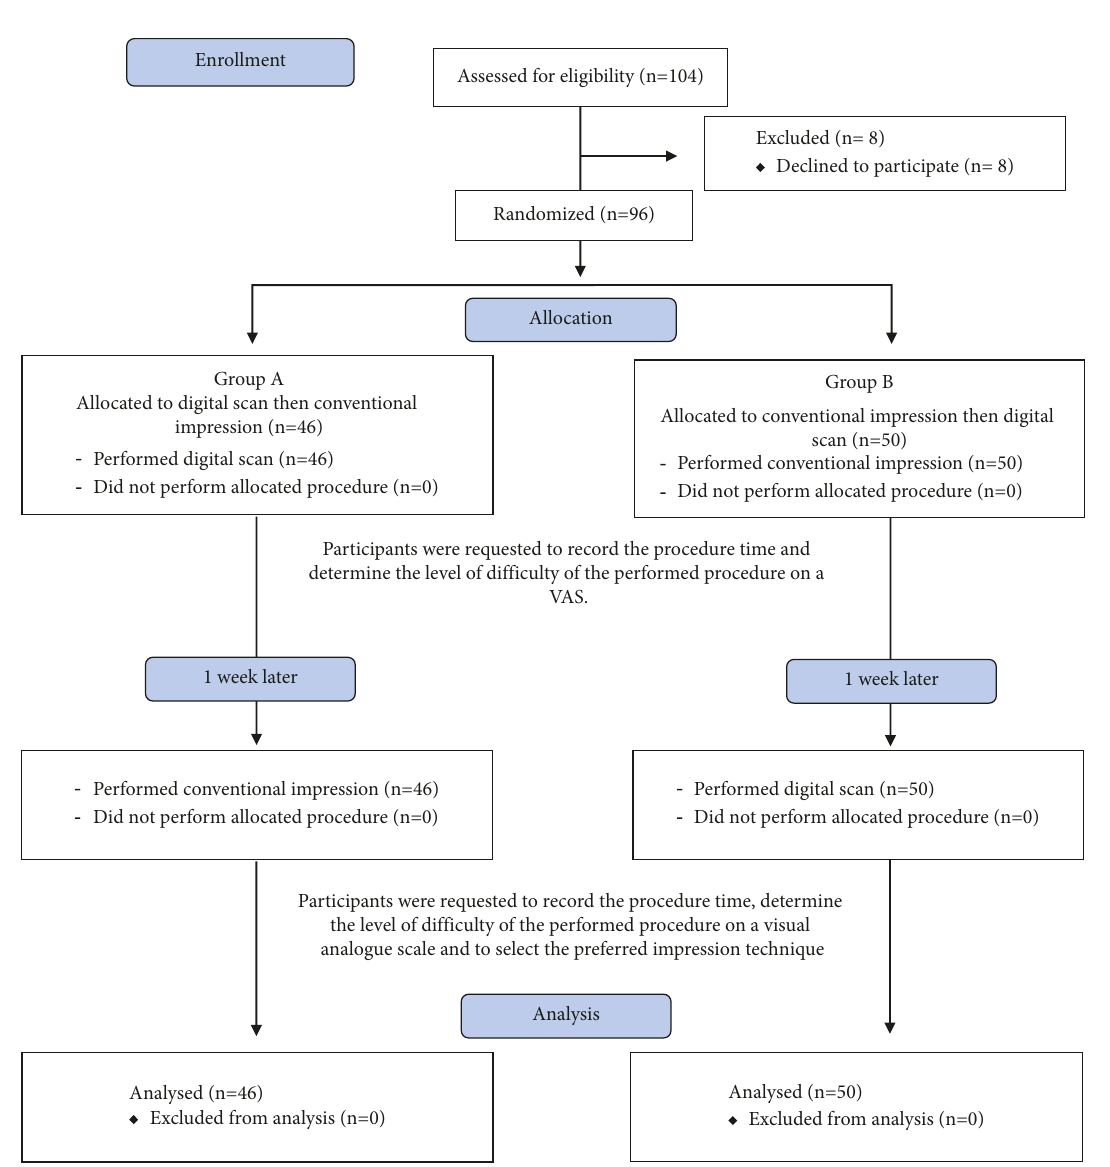
Figure 1: CONSORT 2010 flow